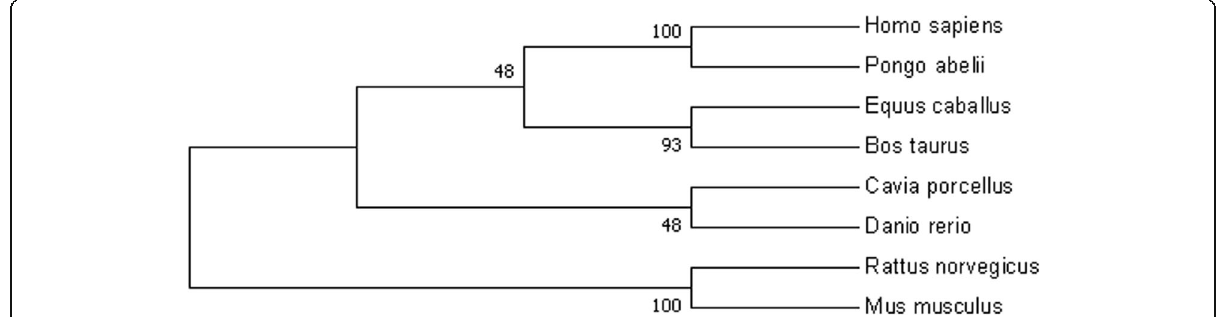
Fig. 2 The phylogenetic tree of PRRT2 proteins among different species